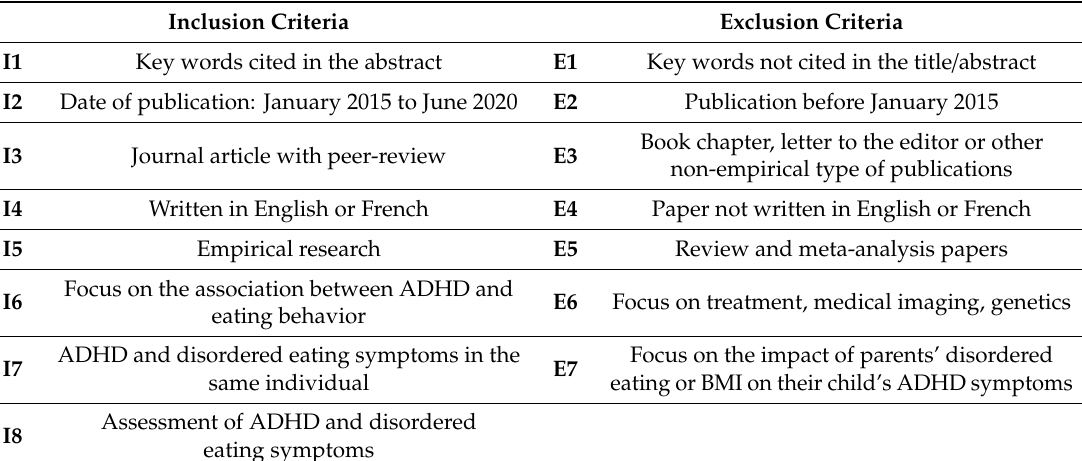
Figure 1. Study selection flow chart. Table 1. Inclusion and exclusion